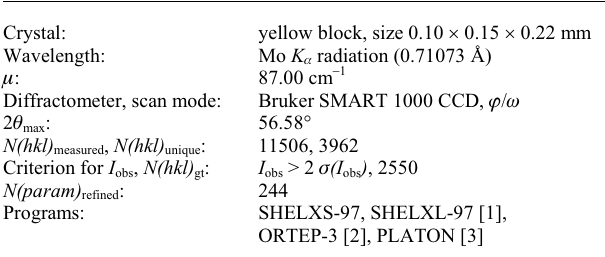
Table 1. Data collection and handling.